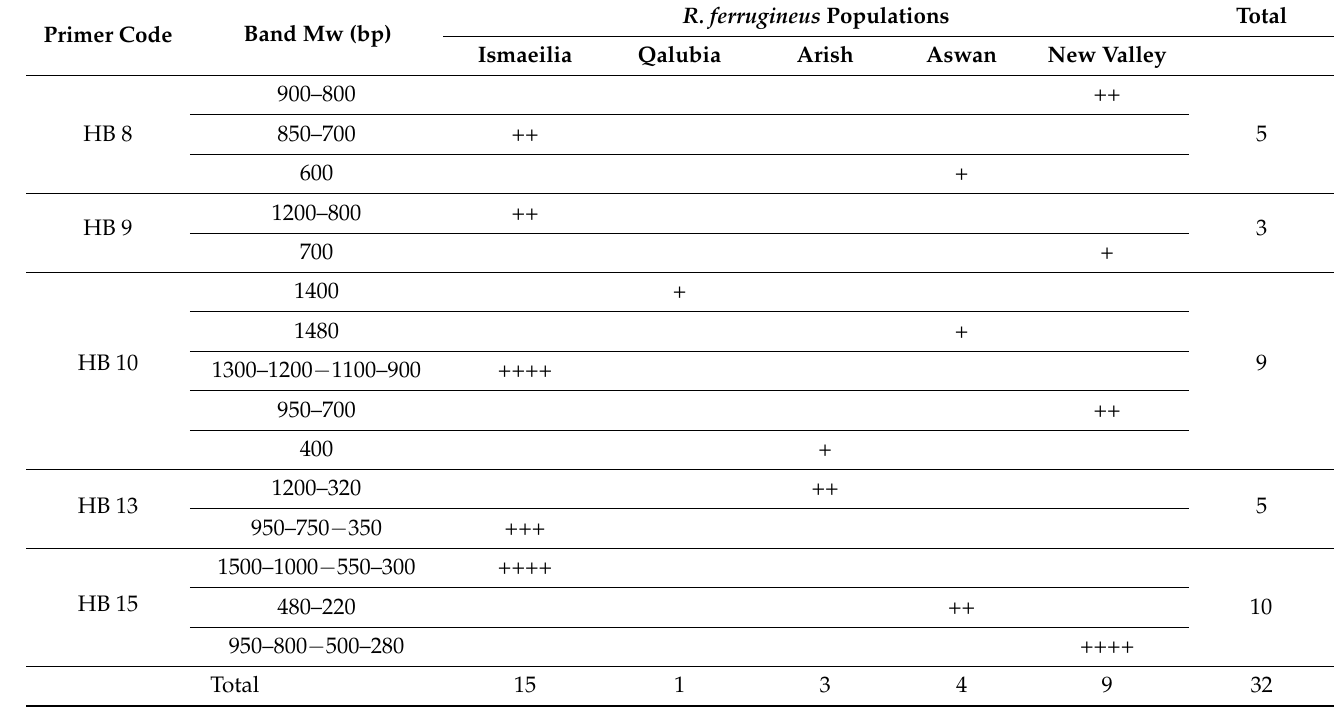
Table 6. Specific markers for R. ferrugineus populations across ISSR-PCR analysis. Primer